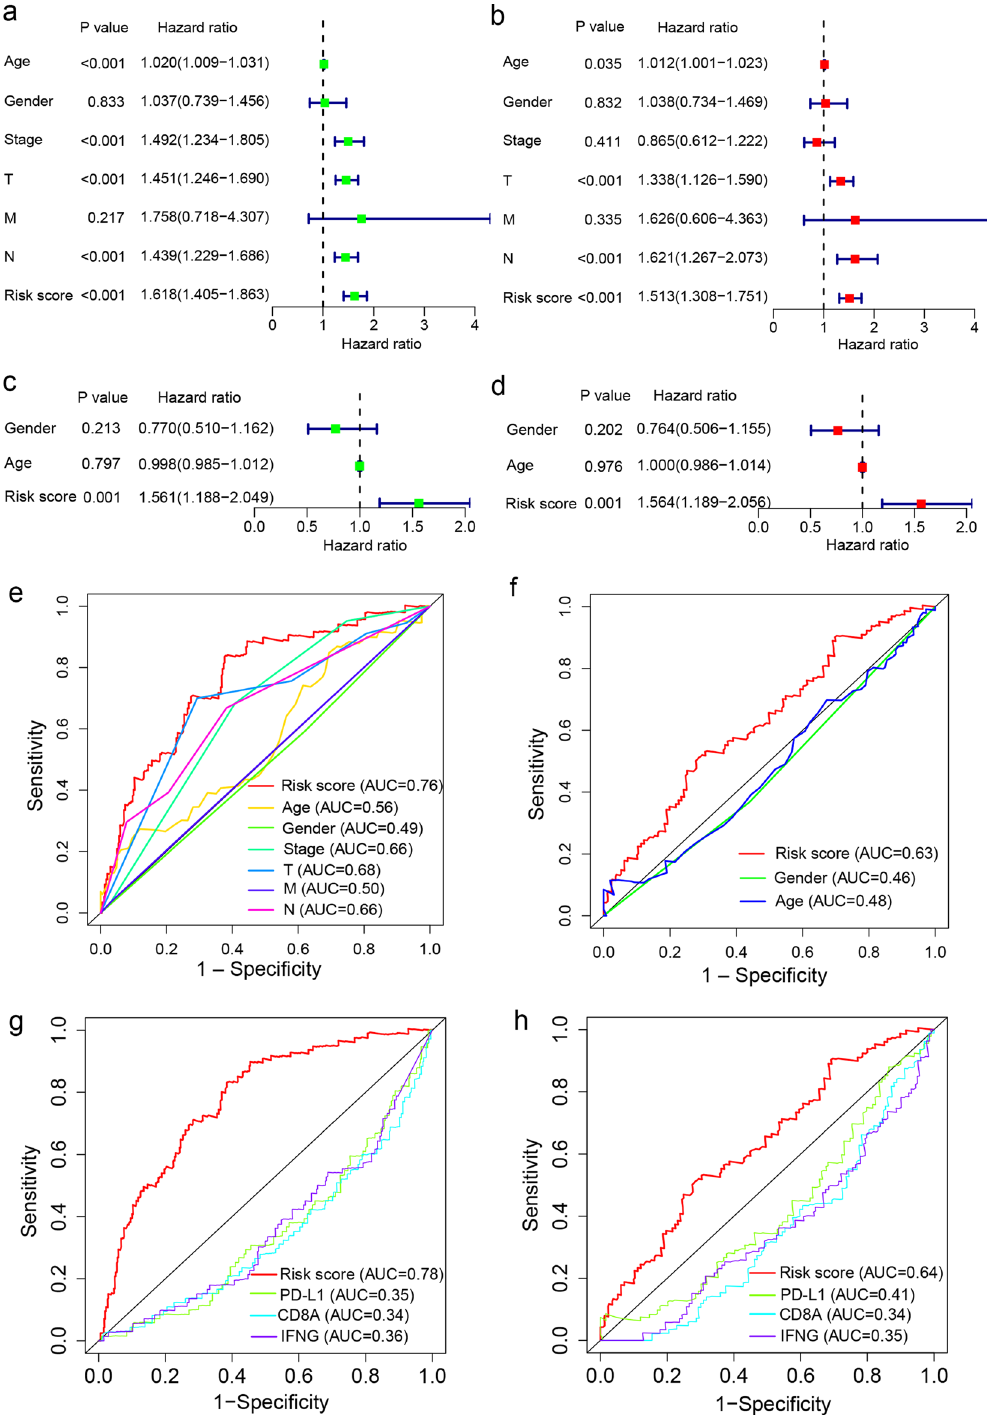
Fig. 4 The Cox regression and ROC analyses of the TIR signature in predicting the survival of melanoma patients. a , b The univariate ( a ) and multivariate ( b ) Cox regression analyses of the TIR risk score, age, gender, stage, and TNM classi fi cation in the TCGA cohort. c , d The univariate ( c ) and multivariate ( d ) Cox regression analysis of the TIR risk score, age, and gender in the GEO validation set GSE65904. In a – d , the colored blocks represent the hazard ratio and the horizontal bars extend from the lower limit to the upper limit of the 95% con fi dence interval of the estimate of the hazard ratio. e Receiver operating characteristics (ROC) curves of the sensitivity and speci fi city of the TIR signature in predicting the overall survival (OS) of patients in the TCGA cohort. The area under the curve (AUC) values for the TIR risk score, age, gender, stage, and TNM classi fi cation were calculated based on the ROC curves of the TCGA cohort. f The AUC values for the TIR risk score, age, and gender were calculated based on the ROC curves of the GEO validation cohort GSE65904. g ROC curves of the sensitivity and speci fi city of the TIR signature and other biomarkers in predicting the OS of patients in the TCGA cohort. h ROC curves of the sensitivity and speci fi city of the TIR signature and other biomarkers in predicting the OS of patients in the GEO validation cohort